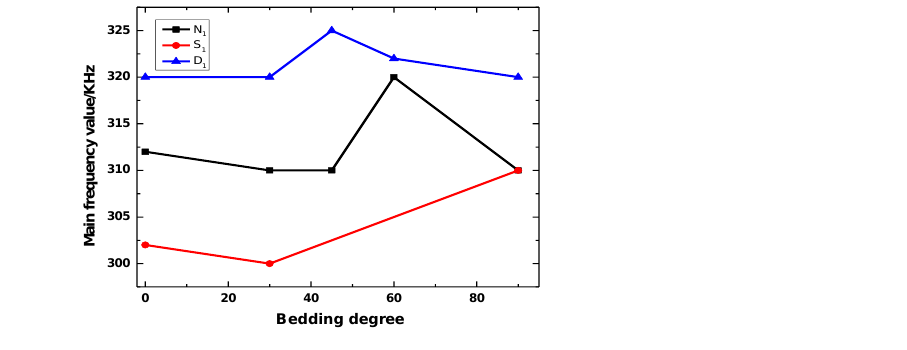
Figure 14. Curves of initial main frequency value with different bedding angles under different water content levels.